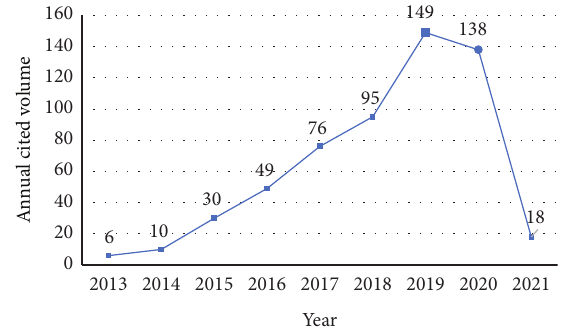
Figure 3: The annual cited volume related to “consumption emotion” during 2011 ∼ 2021. Table 2: The main sources of the scales.